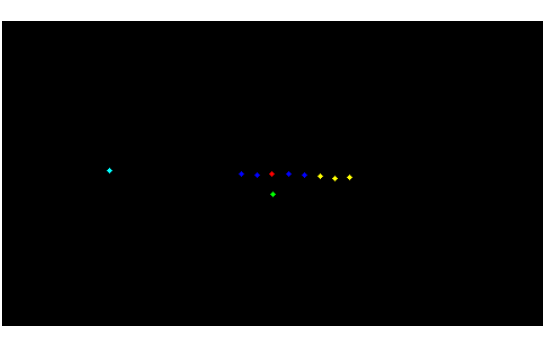
Figure 12. Similar formations—these two formations are very similar with only a one-player dif- ference between the two images: one of the running backs in ( a ) is replaced with a Tight End in ( b